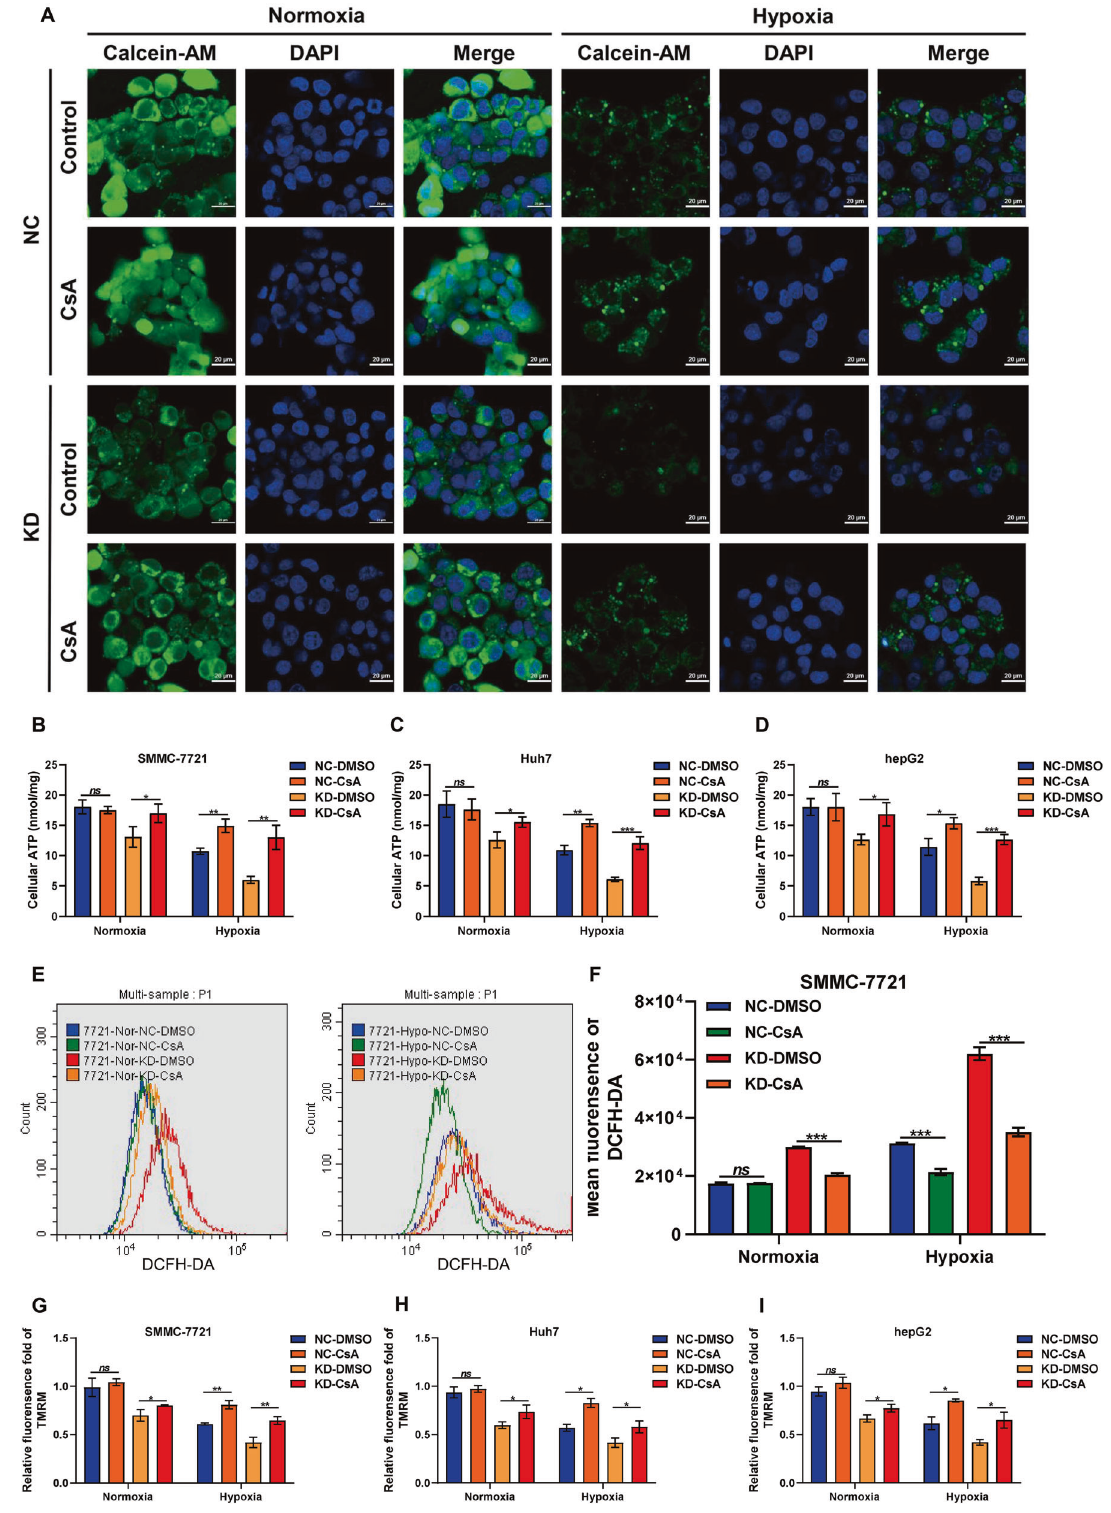
Fig. 5 Damage of mitochondrial function resulted from knockdown of HABON under hypoxia was mediated by mPTP opening. A Transfect siHABON or its control into liver cancer cells, and cells were cultured under normoxia or hypoxia with or without CsA (5 μ M) for 24 h. Perform mPTP assay in each group of hepG2 cells and the opening of mPTP was visualized and measured by confocal microscopy. B – D Measure the cellular ATP content. Three independent experiments, two-tailed Student ’ s t -test. E , F Quanti fi cation of ROS content in each group of SMMC-771 cells by DCFH-DA fl ow cytometry. And the statistics of mean fl uorescence were shown. G – I Mitochondrial membrane potential in each group of samples were measured by TMRM fl ow cytometry and relative fl uorescence intensity was calculated. Error bars stand for mean ± SD. Three independent experiments, two-tailed Student ’ s t -test. * p < 0.05, ** p < 0.01, *** p < 0.001.